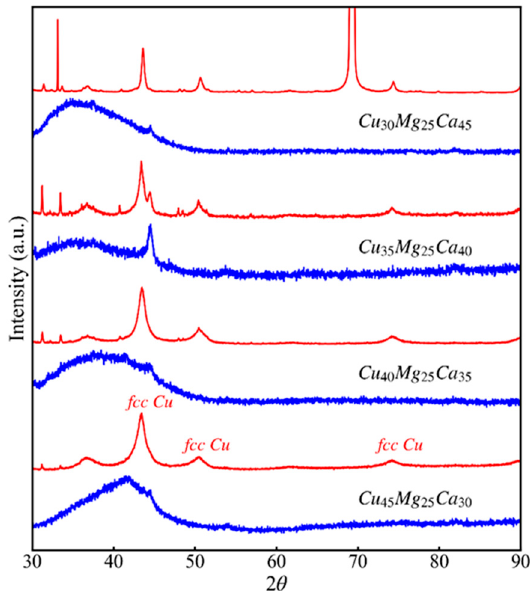
Figure 6. Comparison of XRD patterns of as-quenched (blue) and de-alloyed (red) Cu 30 Mg 25 Ca 45 , Cu 35 Mg 25 Ca 40 , Cu 40 Mg 25 Ca 35 and Cu 45 Mg 25 Ca 30 ribbons. The three peaks corresponding to the fcc copper structure are indicated in one of the spectra.